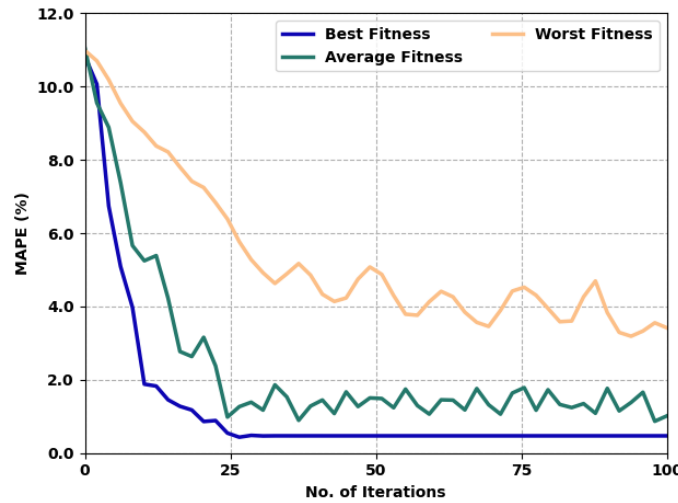
Figure 3. MAPE analysis of AST2FP-OHDBN approach with distinct count of iterations. Table 2. Traffic flow analysis of AST2FP-OHDBN approach with distinct runs.